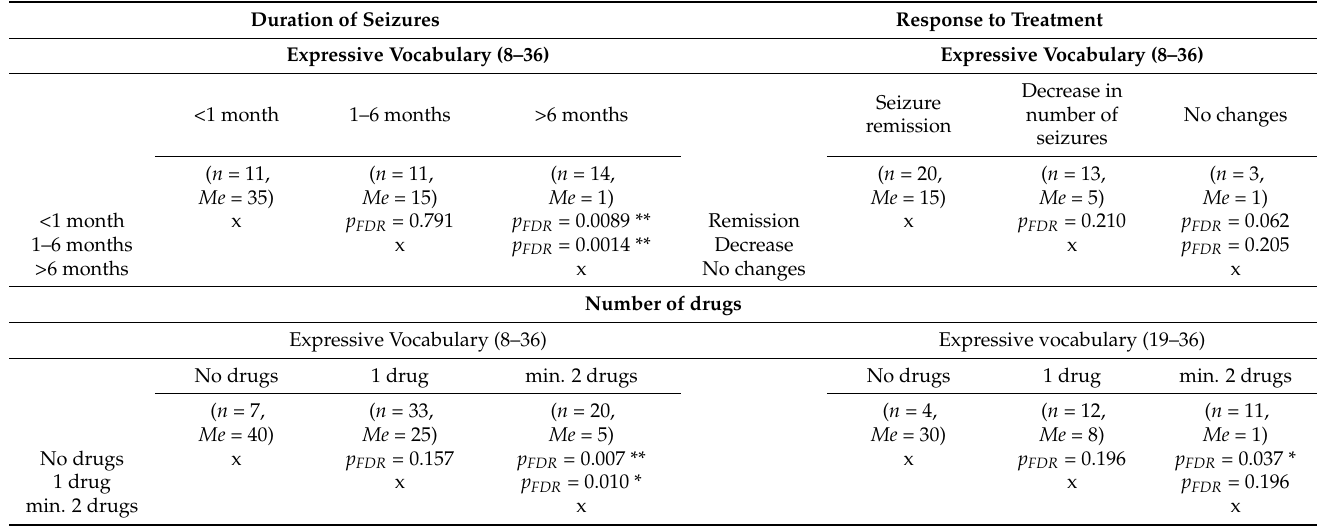
Table 3. Results of post-hoc analyses for the tested variables in expressive vocabulary,